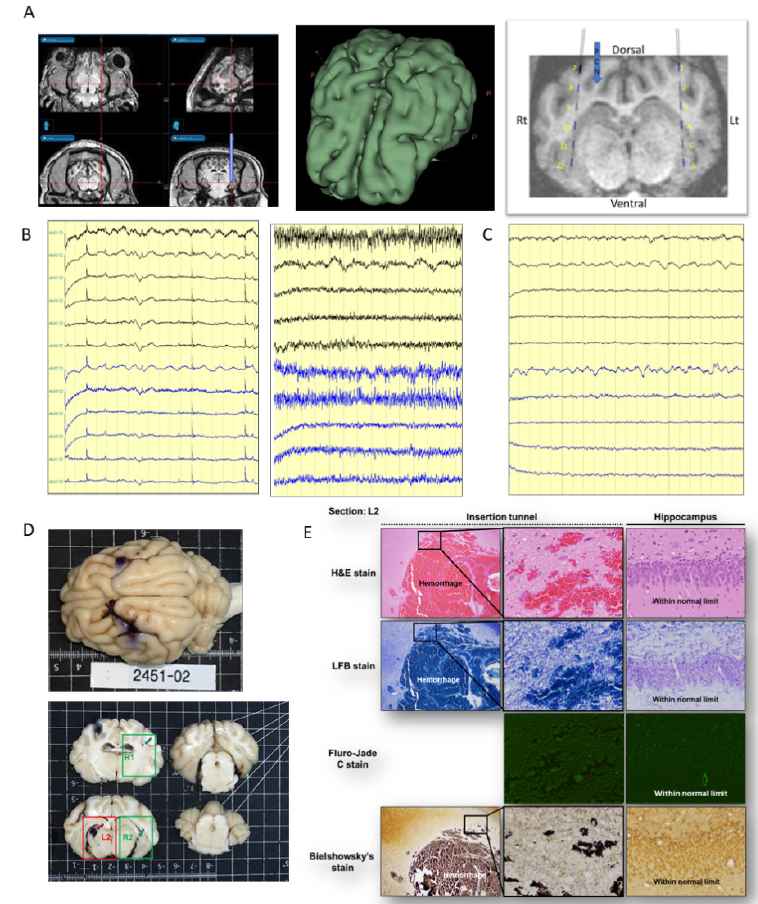
Figure 2. ( A ) The neuro-navigation plan for the depth electrodes implanted at bilateral hippocampi and the subcortical injection of the PCN. ( B ) Epileptic form discharge induced by the PCN injection. The paroxysmal sharp waves ( left ) progressed to the generalized polyspike ( right ) 20 min after the 5 µ L PCN injection in one pig. ( C ) The polyspike was attenuated after stimulation with 5 mV. ( D ) Gross and slice view of the pig brain to confirm the depth electrode trajectories. ( E ) Histopathology exam revealed no neuronal or axonal injury after the stimulation.